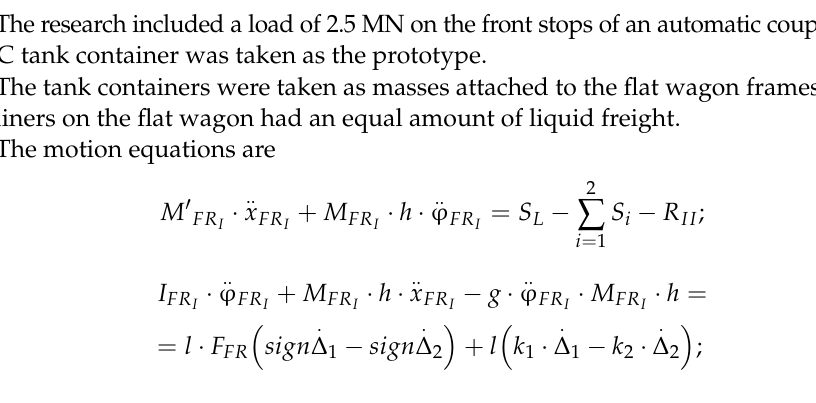
Figure 2. The design diagram of the flat wagon.